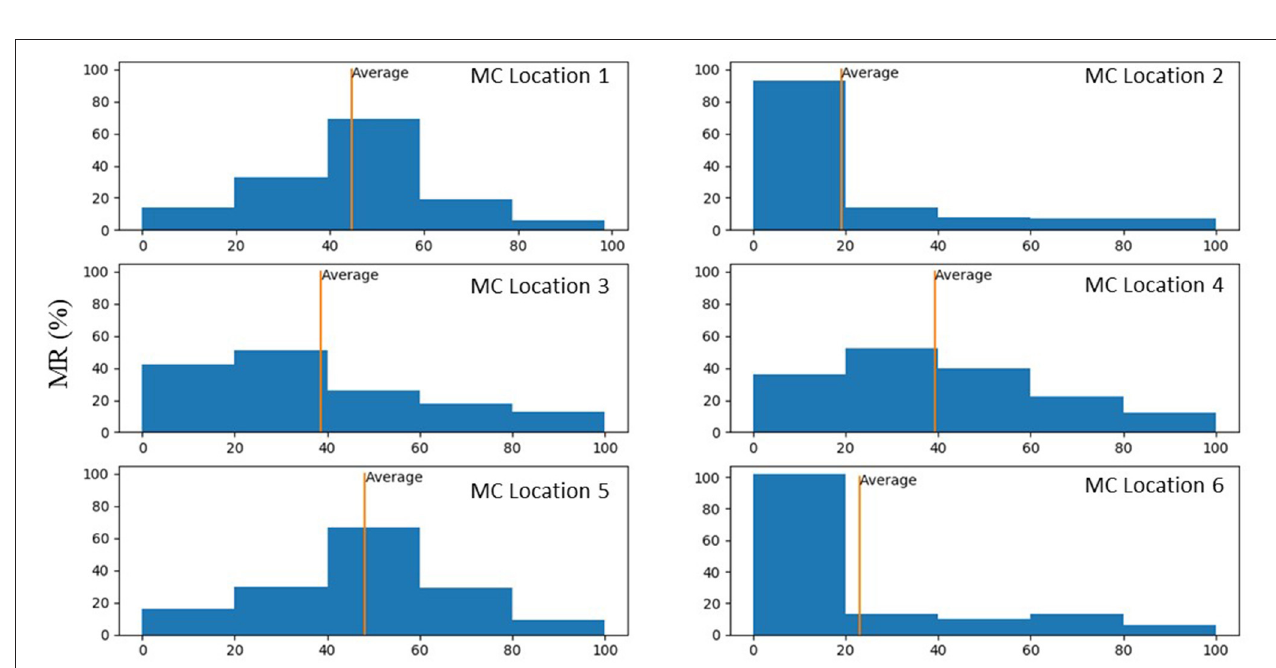
FIGURE 8 | The MR for “No Clip” and 6 locations for a single MC (the same geometry).